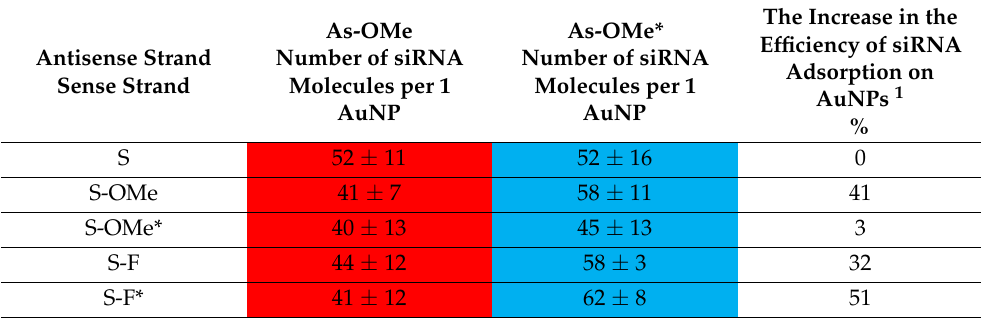
Table 2. A comparison of the adsorption of an siRNA containing the PG modification in the antisense strand with a similar siRNA without the modification of internucleotide phosphate in the antisense strand.